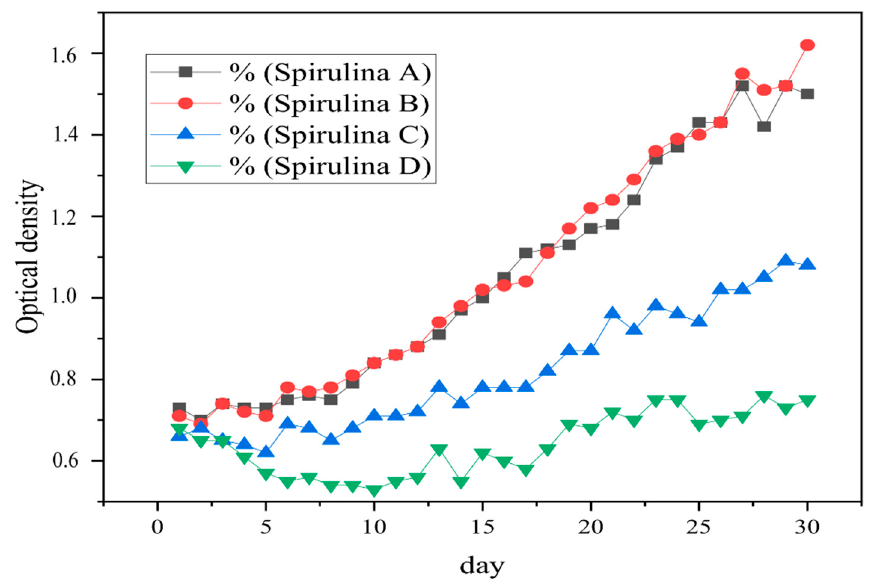
Figure 2. Brackish water culture S. platensis growth in each treatment ( Spirulina A is a control (without Styrofoam), Spirulina B = 150 mg Styrofoam/500 mL culture, Spirulina C = 250 mg Styrofoam/500 mL culture, Spirulina D = 400mg Styrofoam/500 mL culture).